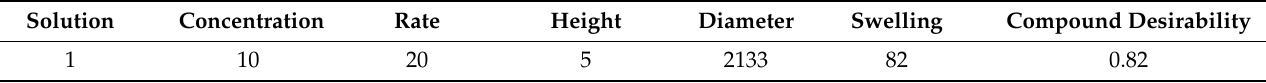
Table 5. Response of the optimization analysis made on Minitab.